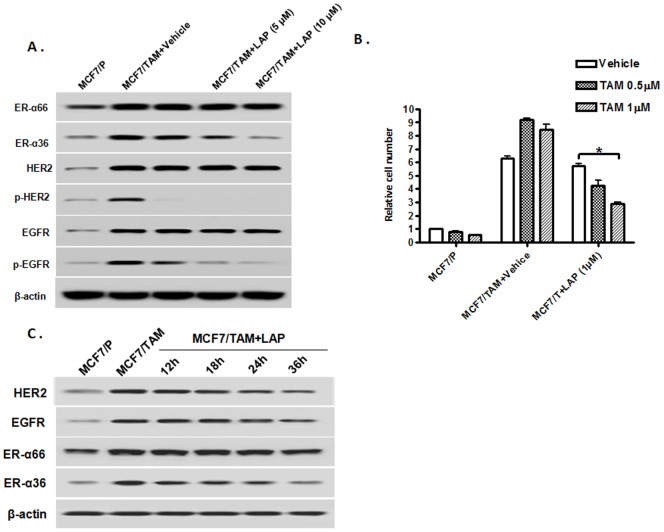
Dual kinase inhibitor Lapatinib downregulates ER-α36 expression and sensitizes MCF7/TAM cells to tamoxifen.A. Western blot analysis of the expression of ER-α36 and 66 as well as EGFR and HER2, and levels of EGFR and HER2 phosphorylation in parental MCF7 (MCF7/P) and MCF7/TAM cells treated with indicated concentrations of Lapatinib for 12 hours. B. Cells were treated with indicated concentrations of TAM together with vehicle or 1 µM of Lapatinib (LAP) for seven days and the numbers of survived cells were counted. The columns represent the means of three experiments; bars, SE. *, P<0.05 for MCF/TAM cells treated with vehicle vs cells treated with 1 µM of tamoxifen and Lapatinib.